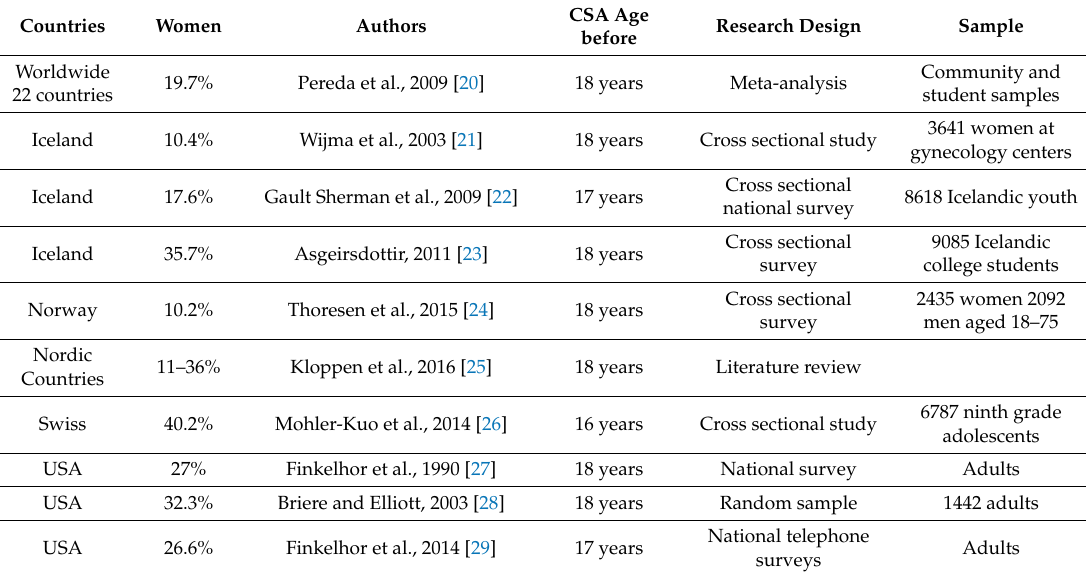
Table 2. The prevalence of CSA in some